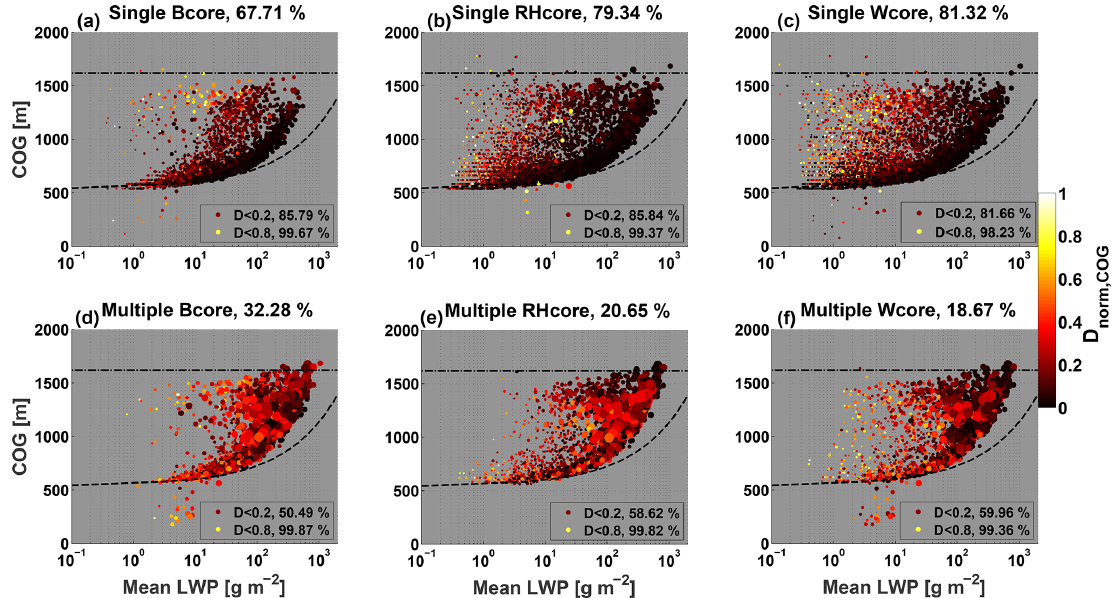
Figure 8. Same as Fig. 7 but for only distances between core COG and cloud COG ( D norm , COG ). Scatter data are partitioned to clouds with a single core (a, b, c) and multiple cores (d, e, f) . The size of each point in the scatter is proportional to the cloud mean